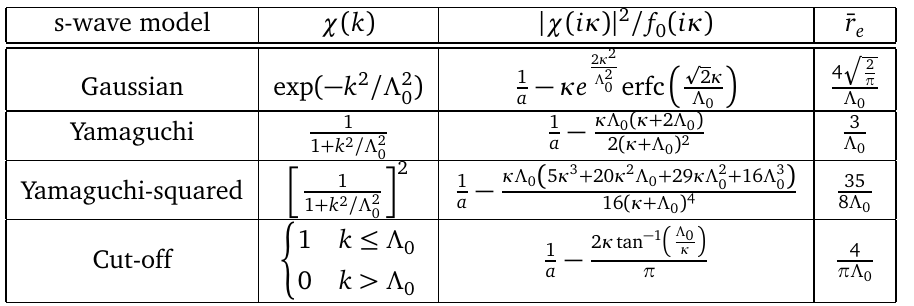
Table 1: Separable potential models used for the s-wave interaction V between a fermion and the particle. For each model, the table provides the explicit expression of the form factor χ , the s-wave scattering amplitude f corresponding to the s-wave effective range at resonance.